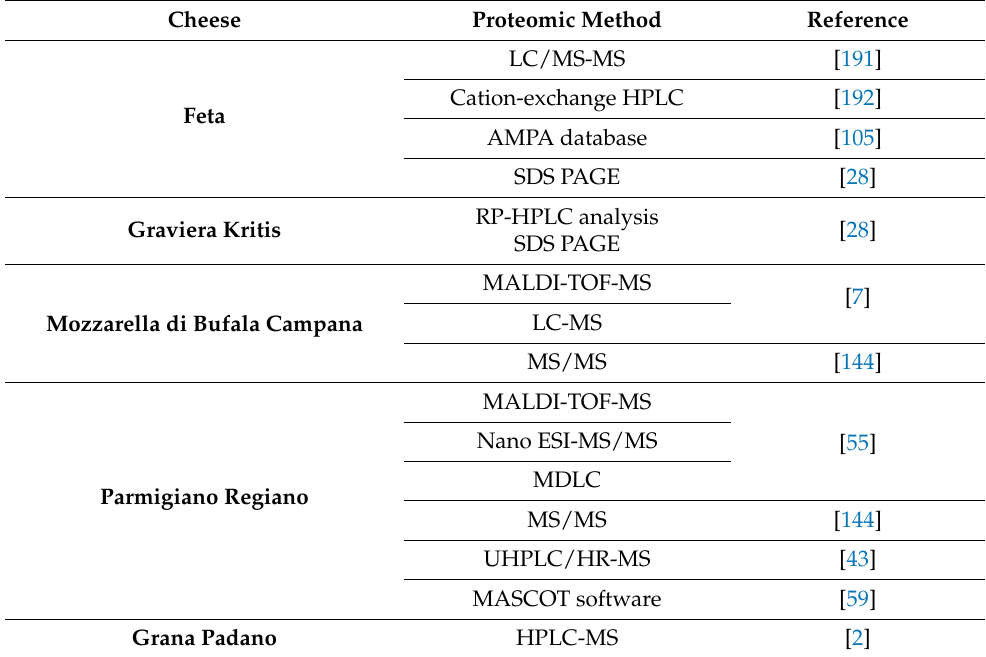
Table 1. A synoptic table describing which proteomic method was used in every cheese.